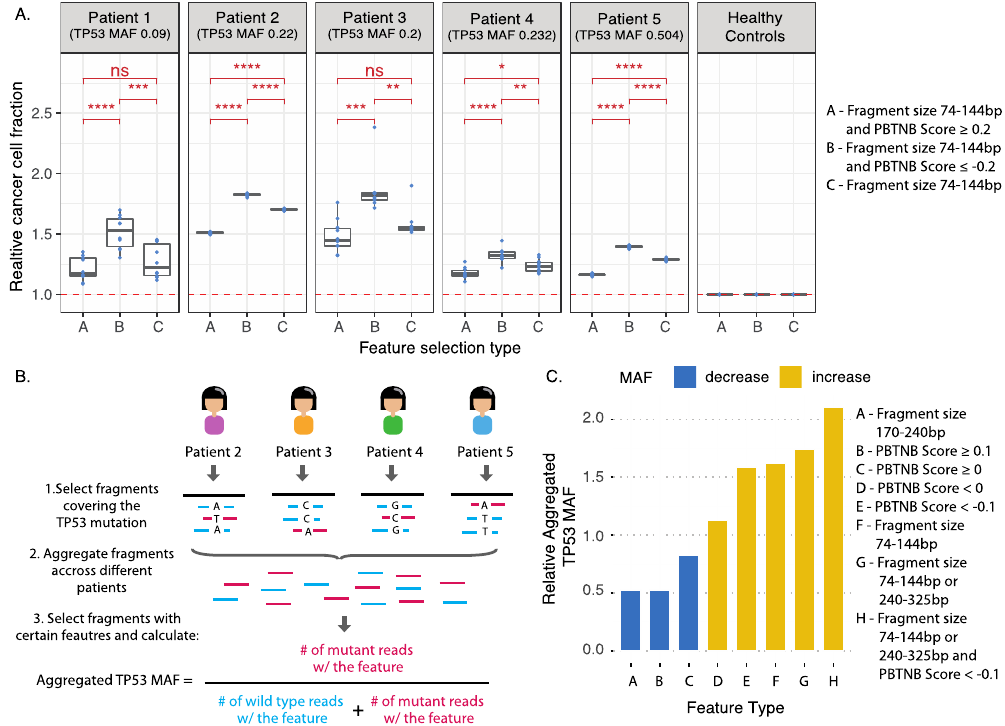
Figure 5. Analysis of fragments selected for multiple features. ( A ) Copy number aberration analysis of all technical replicates containing fragments with different lengths and motif score combinations. ( B ) Aggregated TP53 mutant allele fraction measurements after selecting fragments with various features. The fragments from Patient 2, Patient 3, Patient 4, and Patient 5 were aggregated as these samples had a single point mutation while Patient 1 had an insertion. ( C ) The aggregated TP53 mutant allele fraction is shown relative to the aggregated MAF with no-selection for different fragment feature